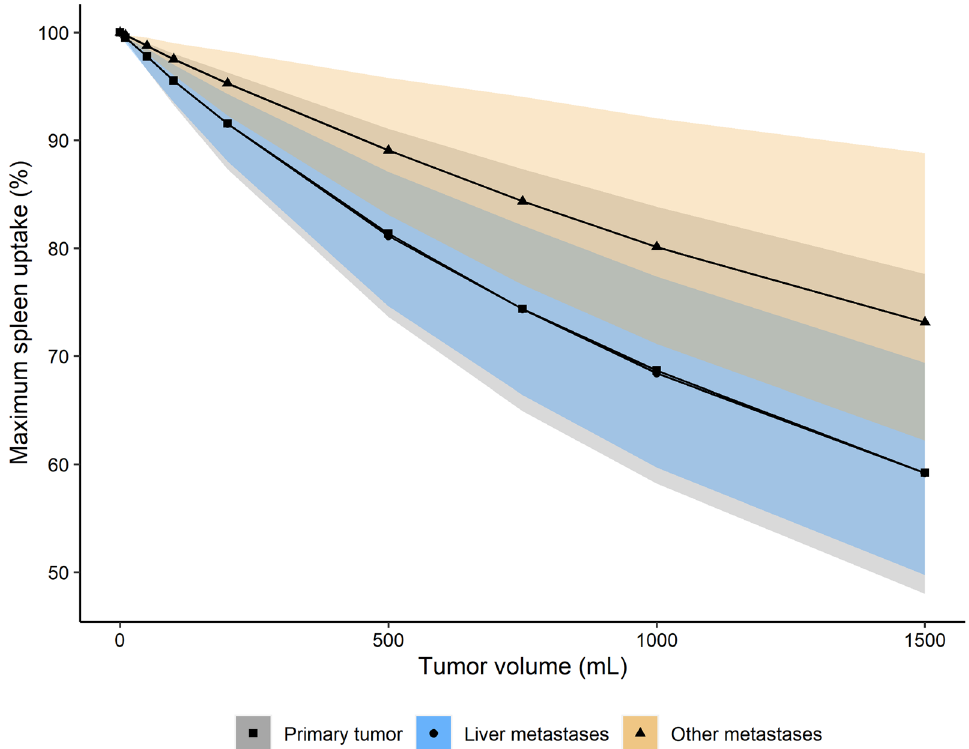
Fig. 5 Predictions of tumor sink effect for each tumor compartment (points and lines) (where primary tumor and liver metastases predictions are overlapping) with ranges in predictions (shaded areas) based on inter‑individual variability of tumor blood flow and tumor blood